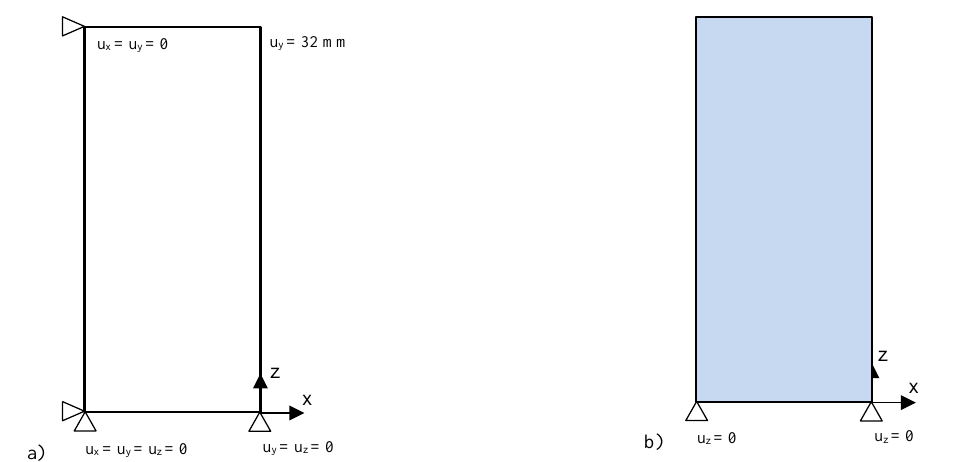
Fig. 9 Finite element model: a) overall view of the geometry, b) meshing of the model